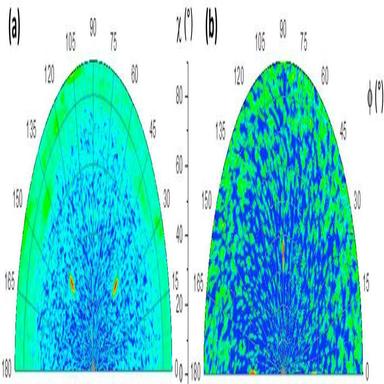
XRD half pole figures around (a) the (111) reflection of the diamond layer; (b) the (111) reflection of the silicon substrate.